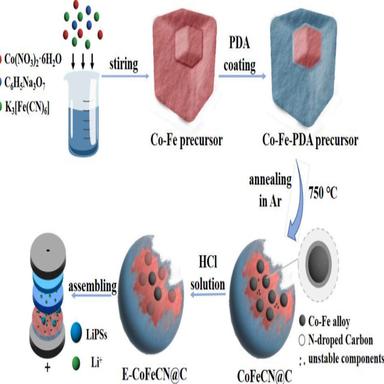
The schematic illustration for the preparation of E-CoFeCN@C.